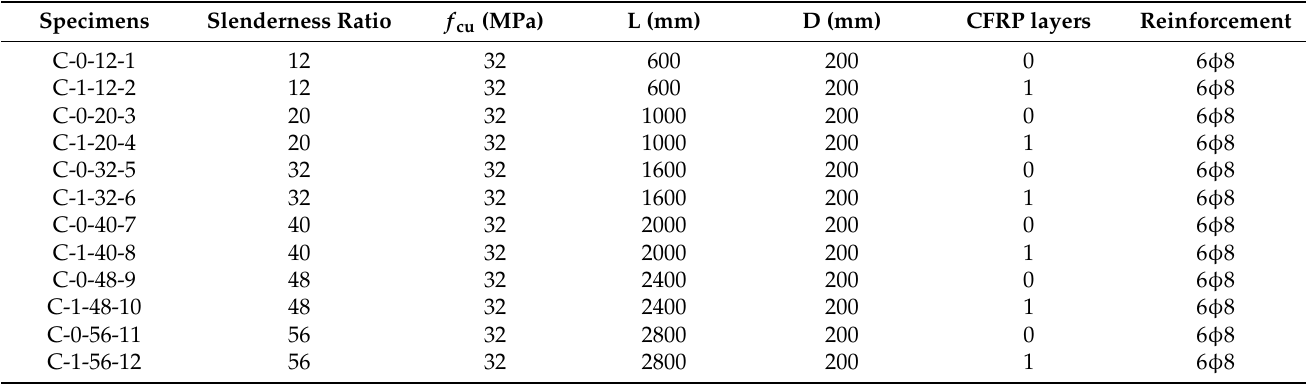
Table 1. Characteristics of test specimens.